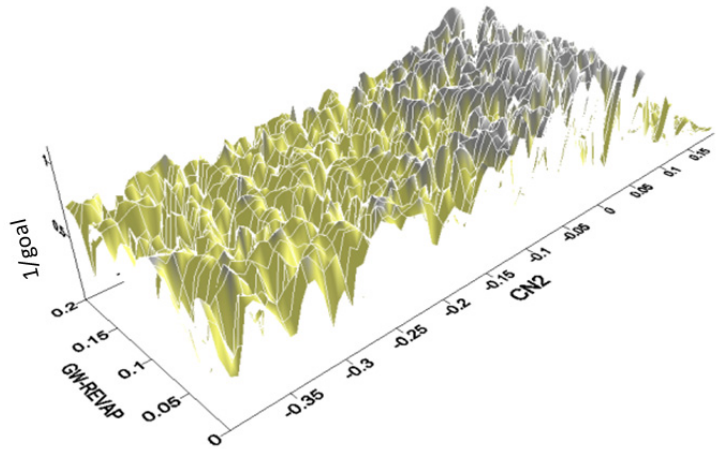
Figure 8. The “multimodal” behavior of the objective function response surface. All red ‐ colored peaks have statistically the same value of objective function, which occur at the different regions in the parameter space.